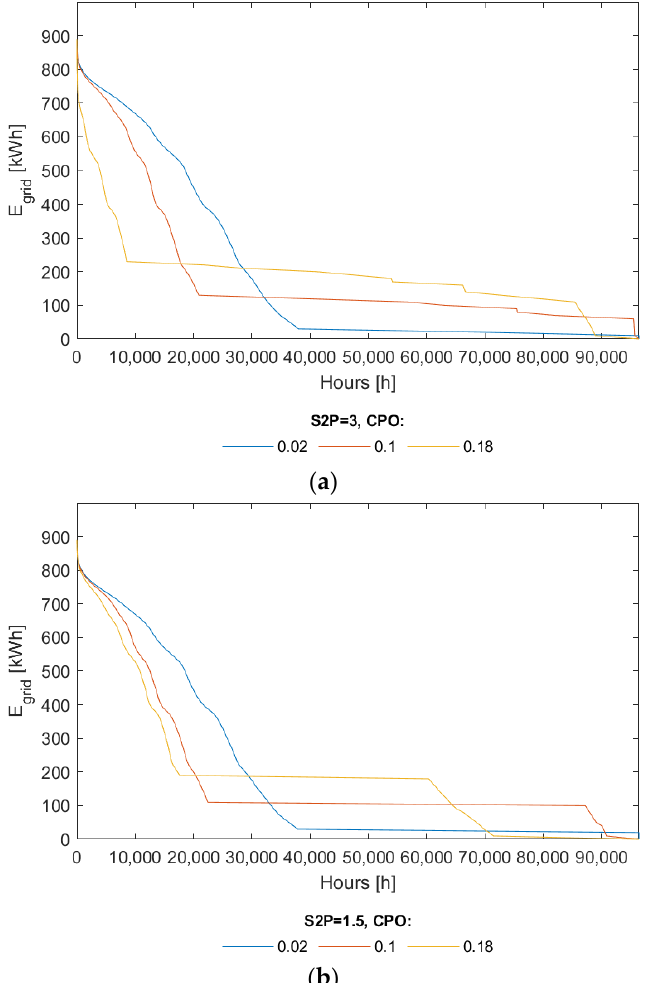
Figure 9. Load duration curves according to S2P ( a ) S2P= 3, ( b ) S2P= 1.5, CPO factor and BESS size.